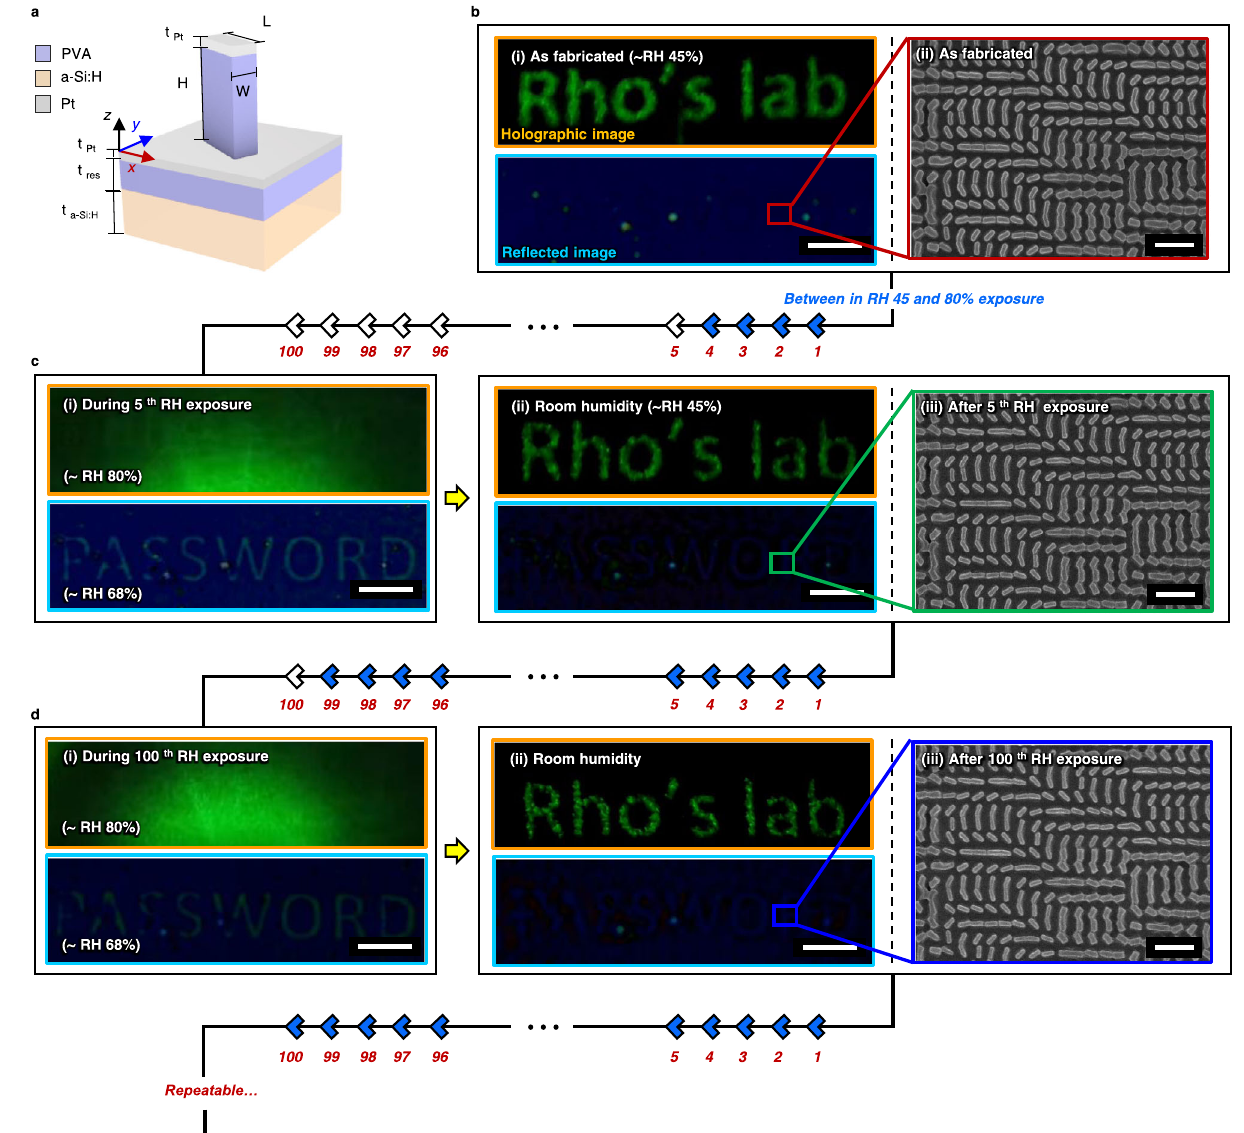
Fig. 5 | Reversible polyvinyl alcohol metasurfaces for a two-channel security platform. a Schematic illustration of a platinum (Pt) coated polyvinyl alcohol (PVA) meta-atom on top of hydrogenated amorphous silicon (a-Si:H). b (i) Photo- graphs of the holographic, and re fl ected images of the Pt-coated PVA meta- surfaces. Scale bar: 50 µ m. (ii) scanning electron microscope (SEM) image of the